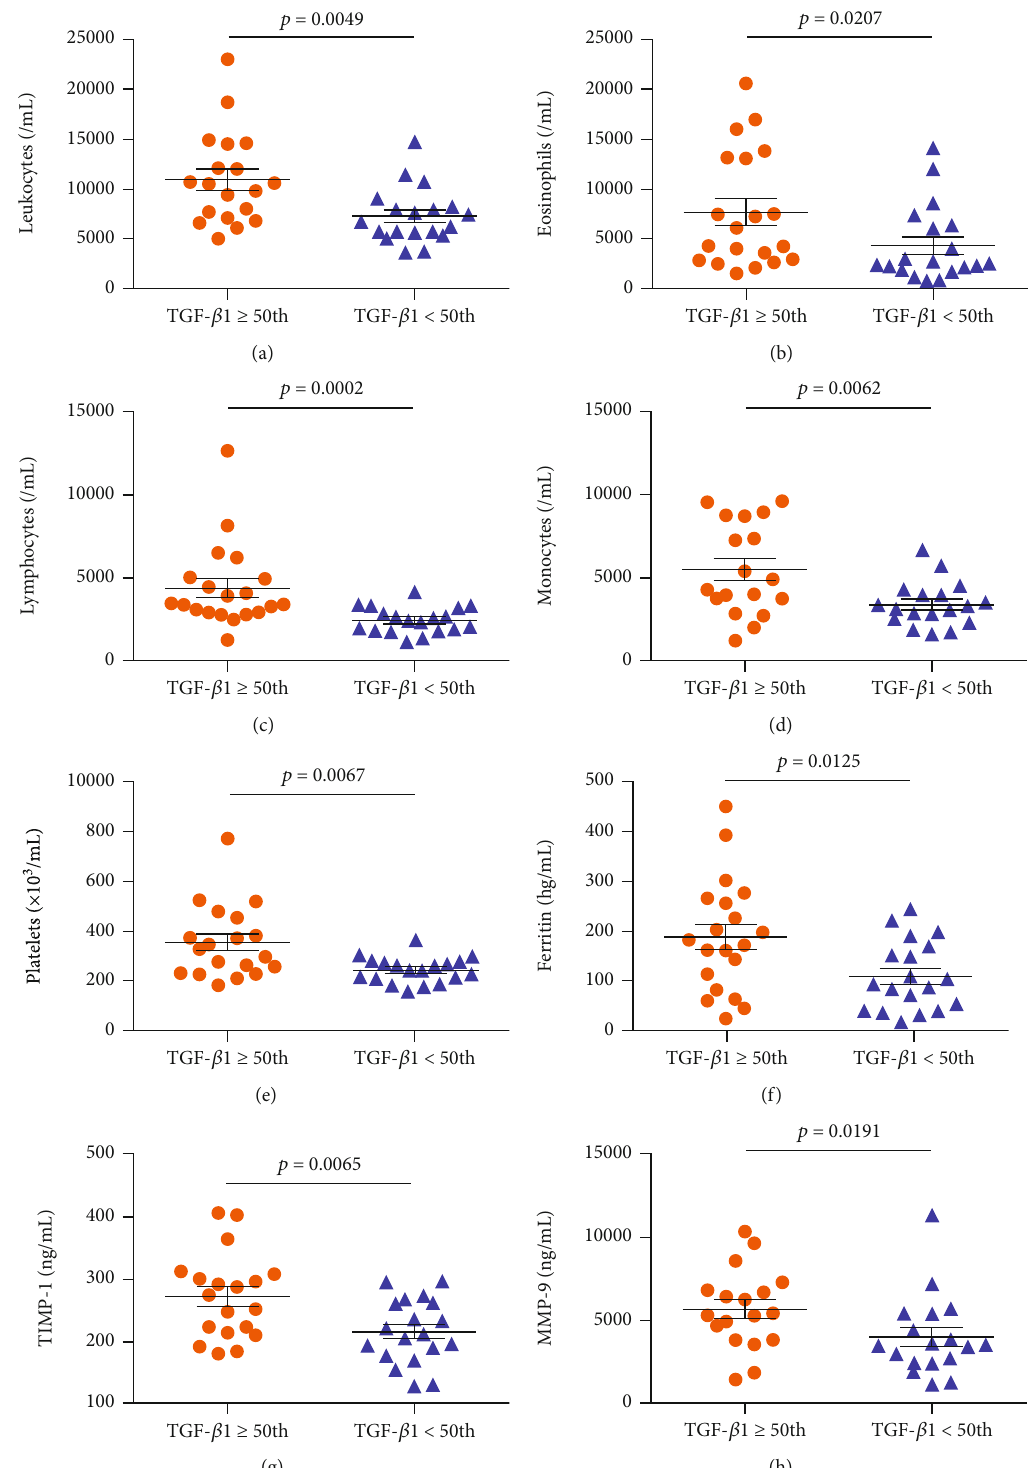
Figure 4: Associations between TGF- β 1 levels and laboratory biomarkers as well as the glycoprotein TIMP-1 and matrixin MMP-9 in individuals with HbSC. Individuals with TGF- β 1 levels above the median ( TGF ‐ β 1 ≥ 47 : 80 ) exhibited increased (a) leukocytes, (b) eosinophils, (c) lymphocytes, (d) monocytes, and (e) platelets, as well as higher levels of (f) ferritin, (g) TIMP-1, and (h) MMP-9. All p values were obtained by the Mann – Whitney U test, except for leukocytes, monocytes, ferritin, and TIMP-1, for which the independent t -test was